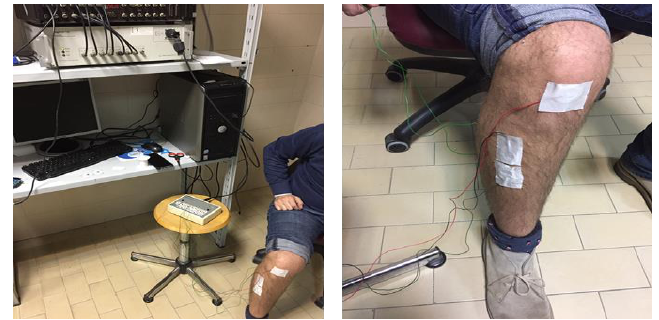
Figure 7. Typical set-up of a sEMG with a conventional wired equipment that is used in biomedical research laboratories.